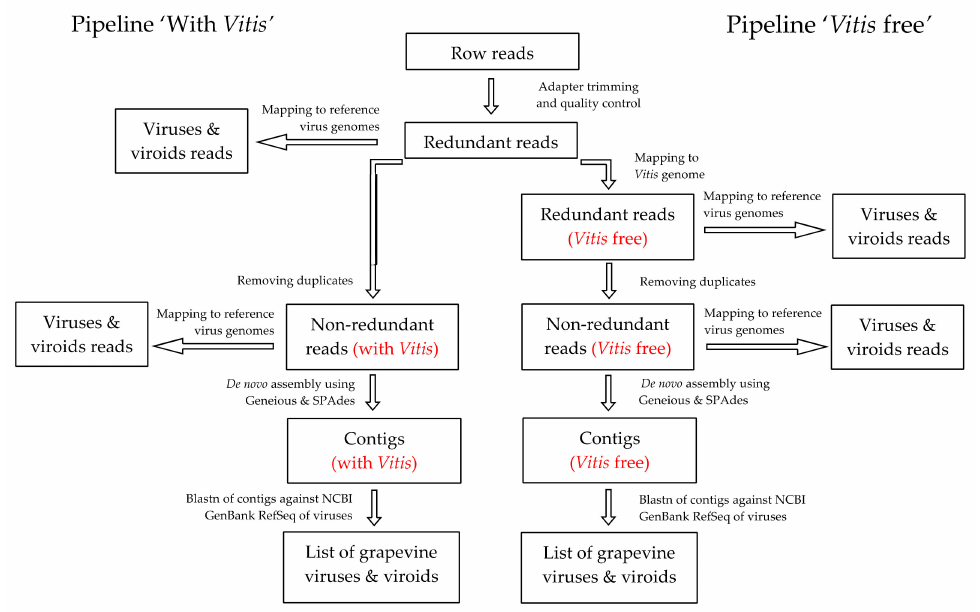
Figure 1. Schematic representation of the bioinformatics pipelines used for virus and viroid detection in the HTS in sRNA